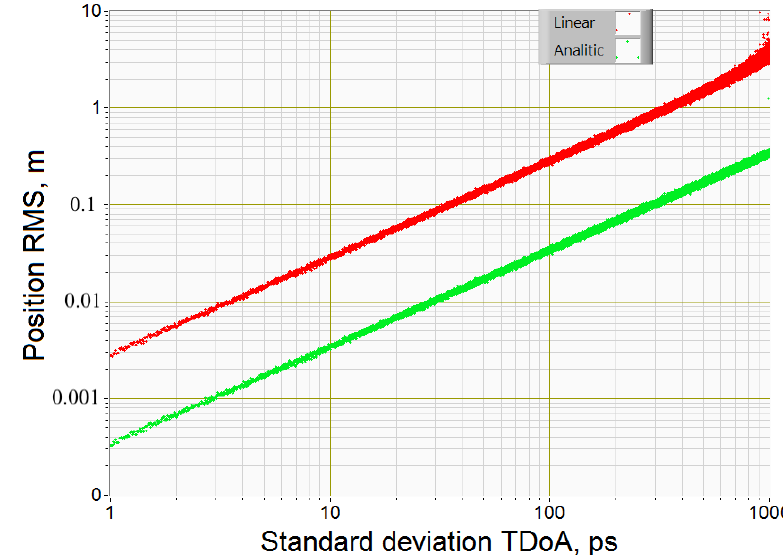
Figure 3. Dependence of the mean square deviation of the object coordinates estimate on the standard deviation of the Gaussian white noise of the difference in arrival time (1 picosecond (ps) = 10 −12 s): red points for the matrix linearization algorithm, green points for the analytical algorithm proposed.